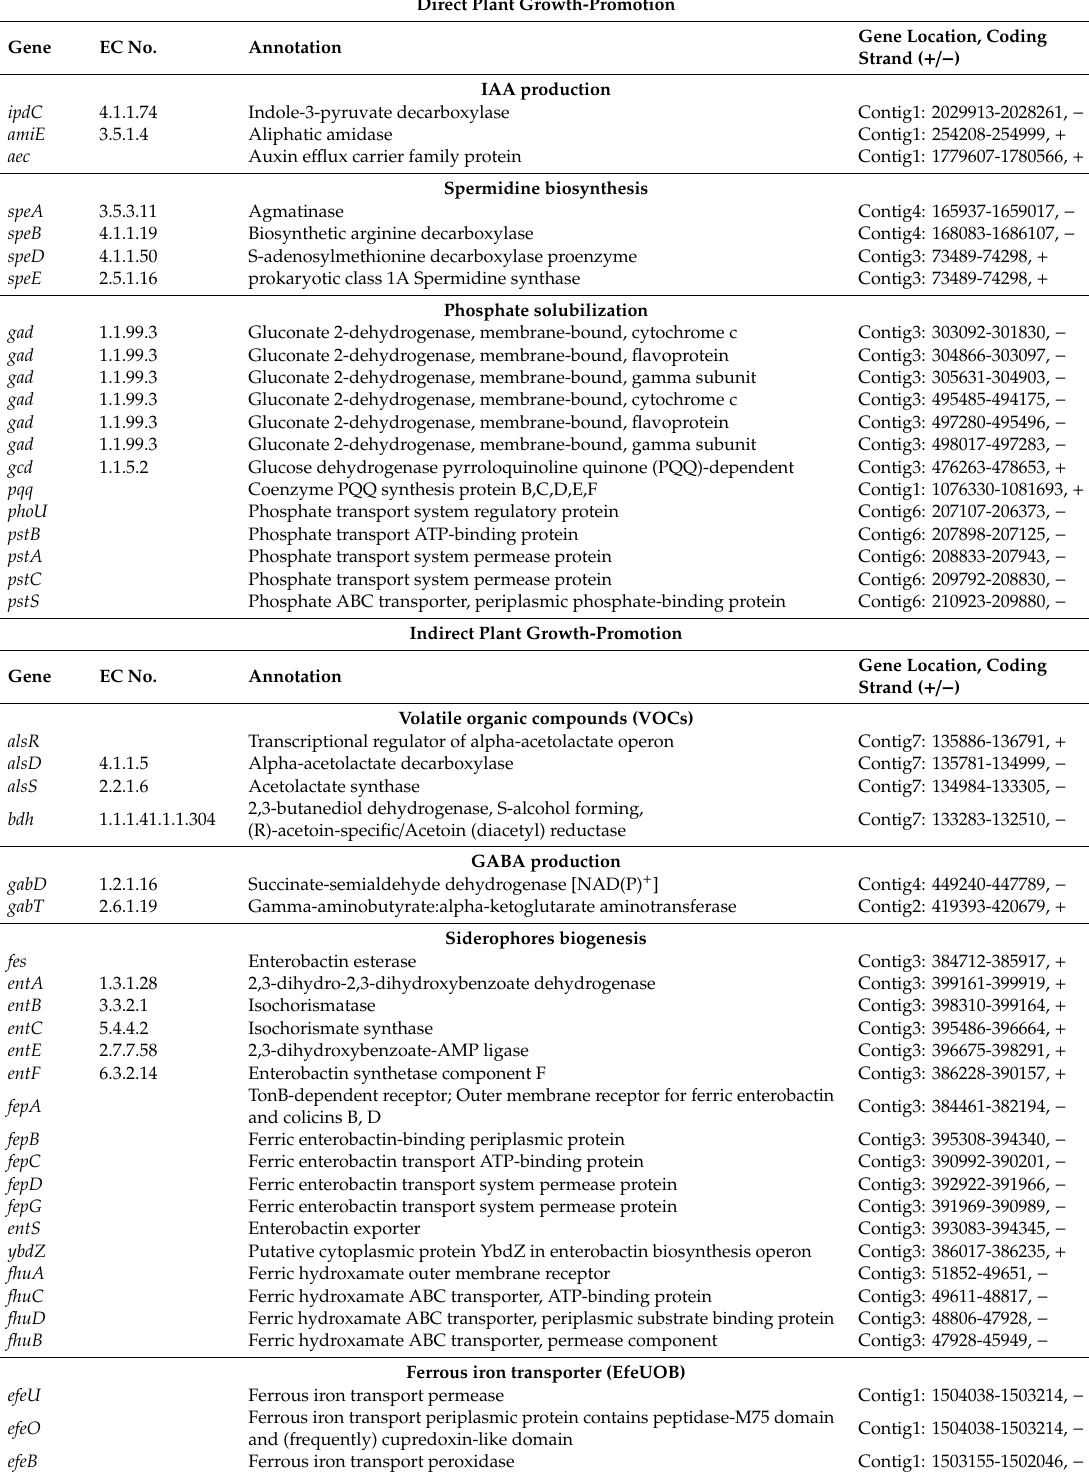
Table 4. Genes potentially associated with Plant Growth-Promotion traits in P. agglomerans C1. Direct Plant